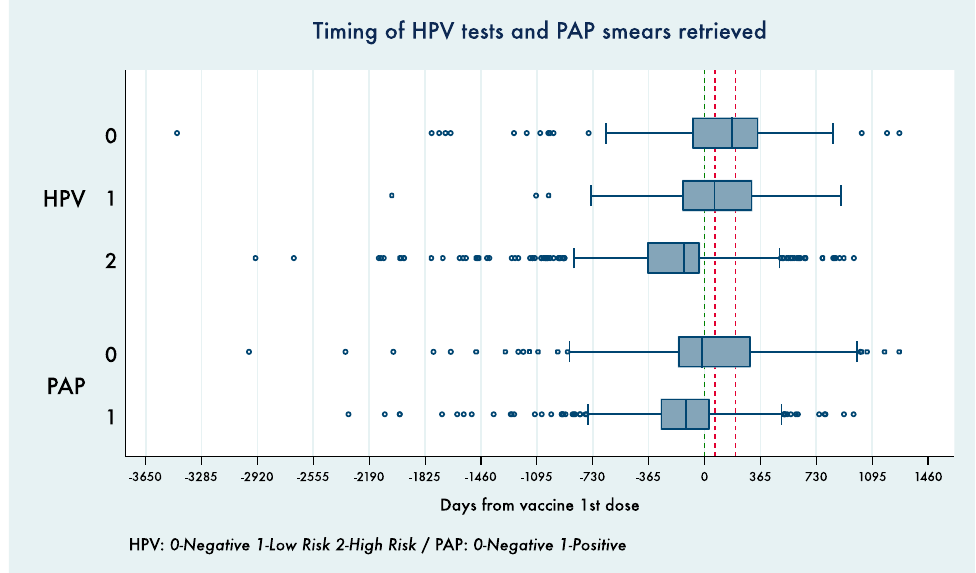
Figure 2. Time distribution for different HPV test and Pap smear results retrieved, where day 0 represents the vaccination 1st dose administration date for each enrolled woman.